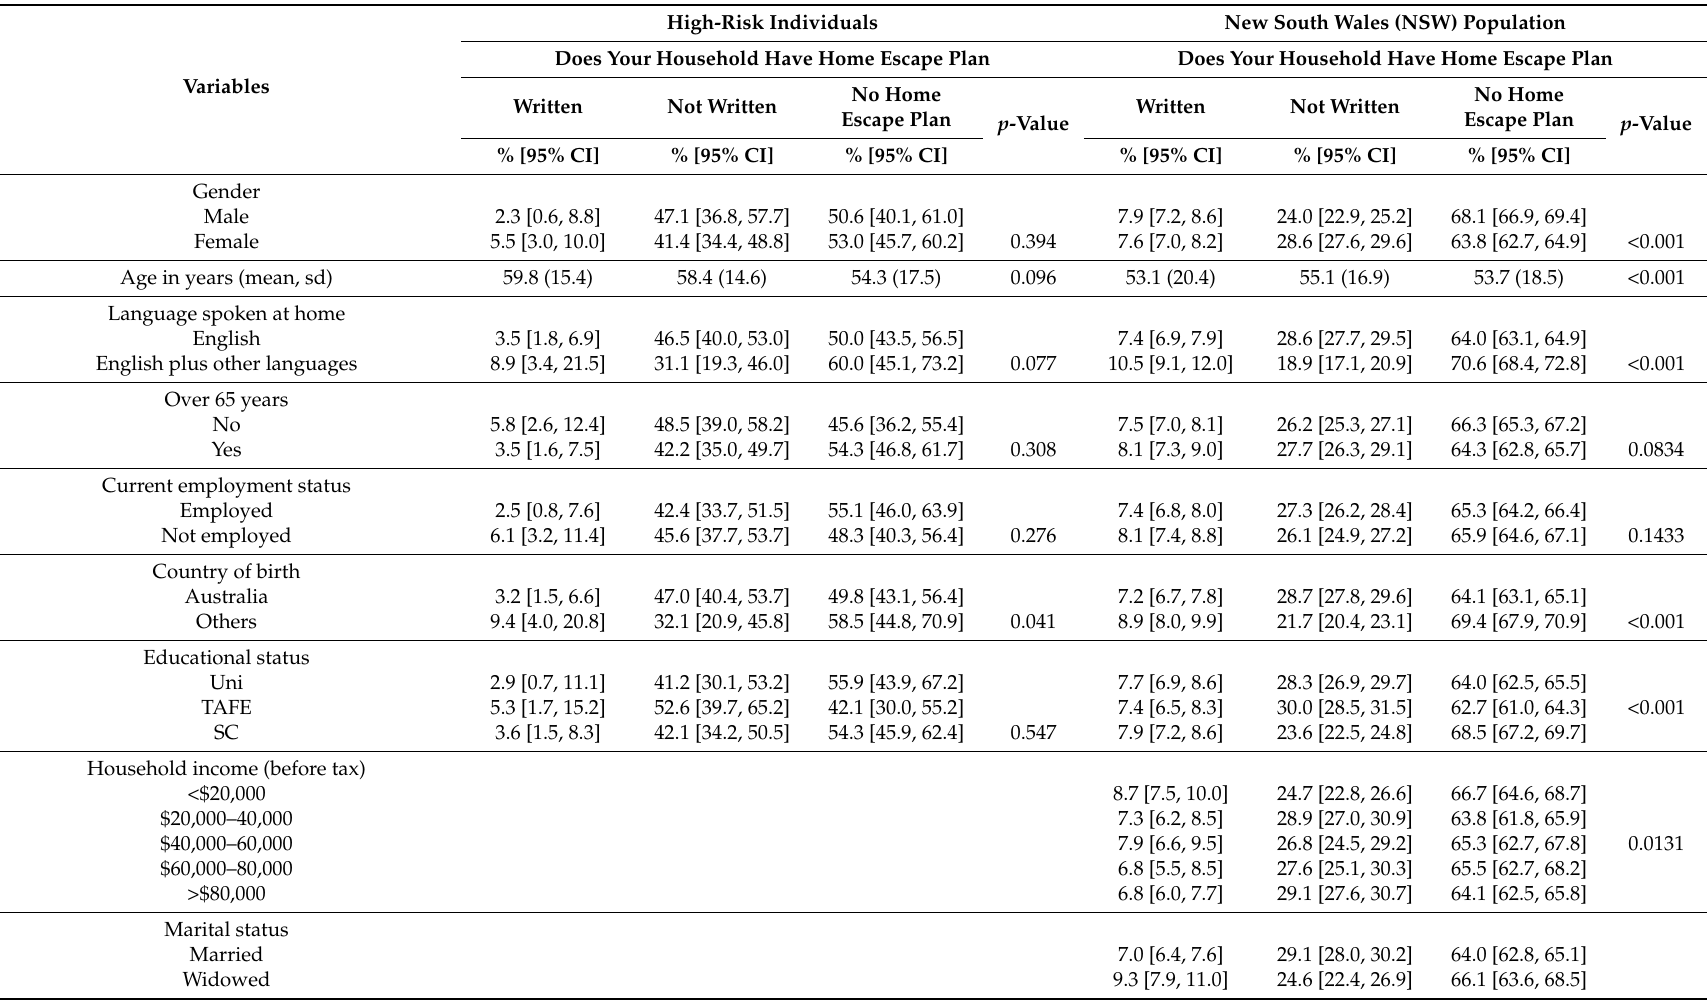
Table 2. Prevalence of home escape plan according to characteristics of the